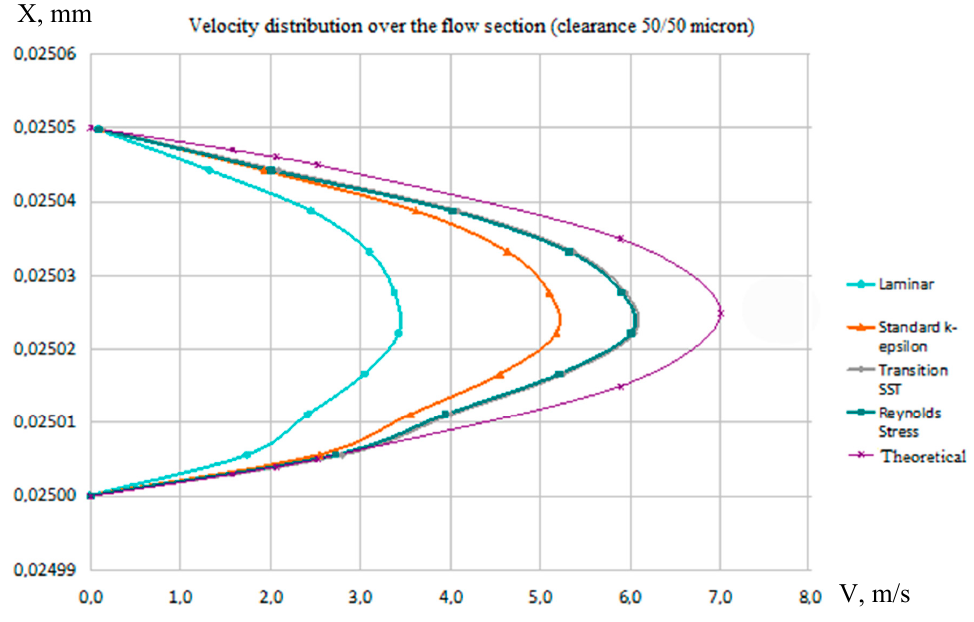
Figure 6. Velocity distribution over the flow section.